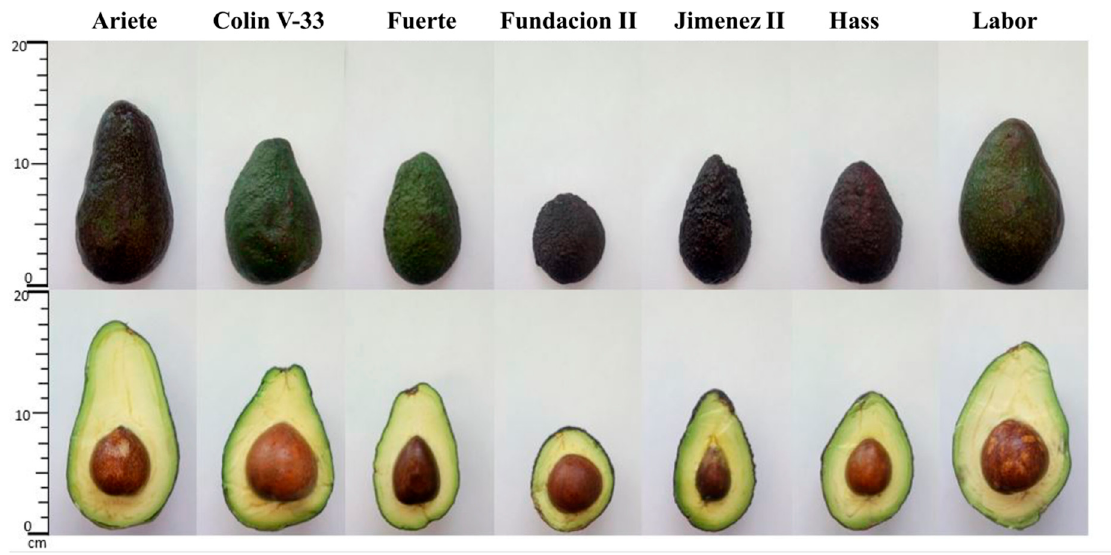
Figure 1. Avocado ( Persea americana ) fruits including commercial and non-commercial cultivars.